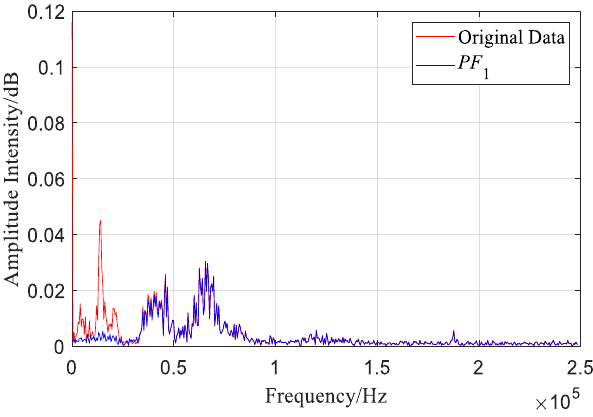
Figure 10. Spectrogram of original arc series and PF 1.